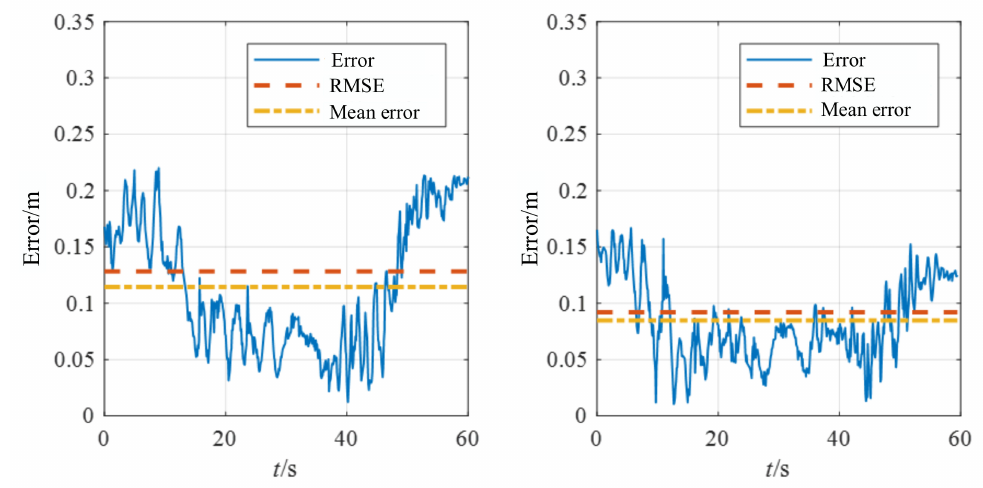
Figure 11. Comparison of the errors using E + I ( left ) with R + E + I ( right ) at maximum speed 3.489 m/s. The left is EVIO using events (E) and IMU (I). The right is REVIO using range (R), events (E) and IMU (I).